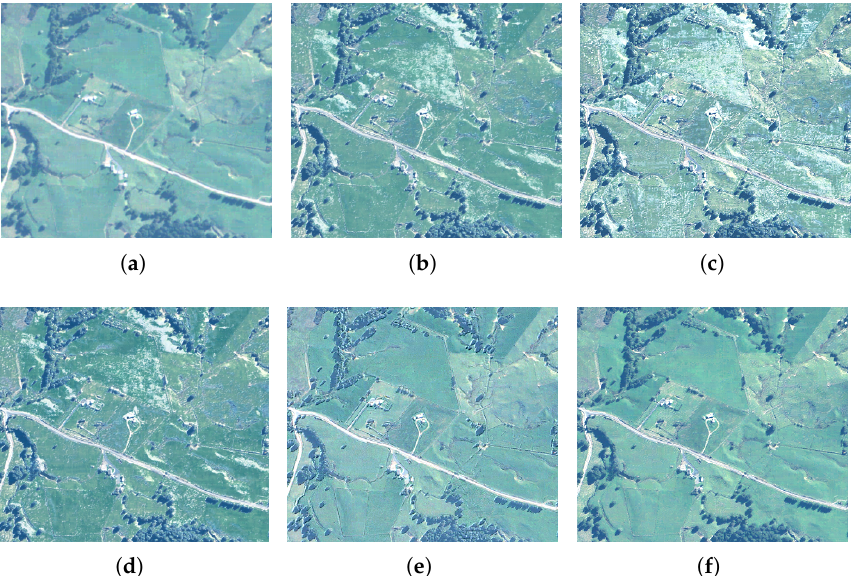
Figure 11. Real experimental results by different methods on QuickBird data. ( a ) Low-resolution MS images; ( b ) AIHS; ( c ) ATWT; ( d ) PNN; ( e ) MSDCNN; ( f ) the proposed method.